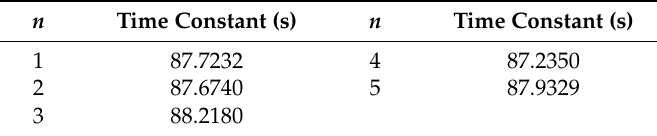
Figure 9. Output signals of the thermocouple. Table 2. Time constant estimates